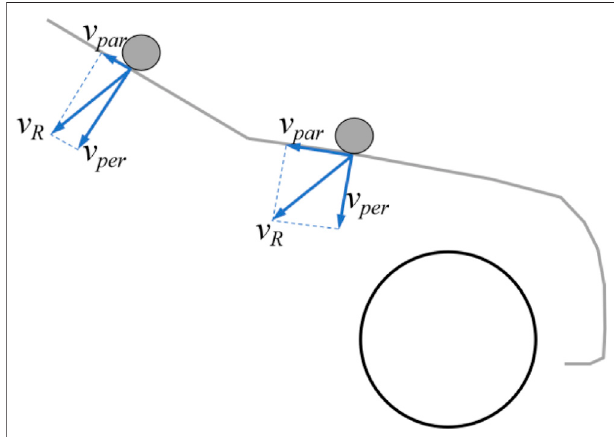
FIGURE 15 | Decomposition of head contact velocity in bonnet and windscreen